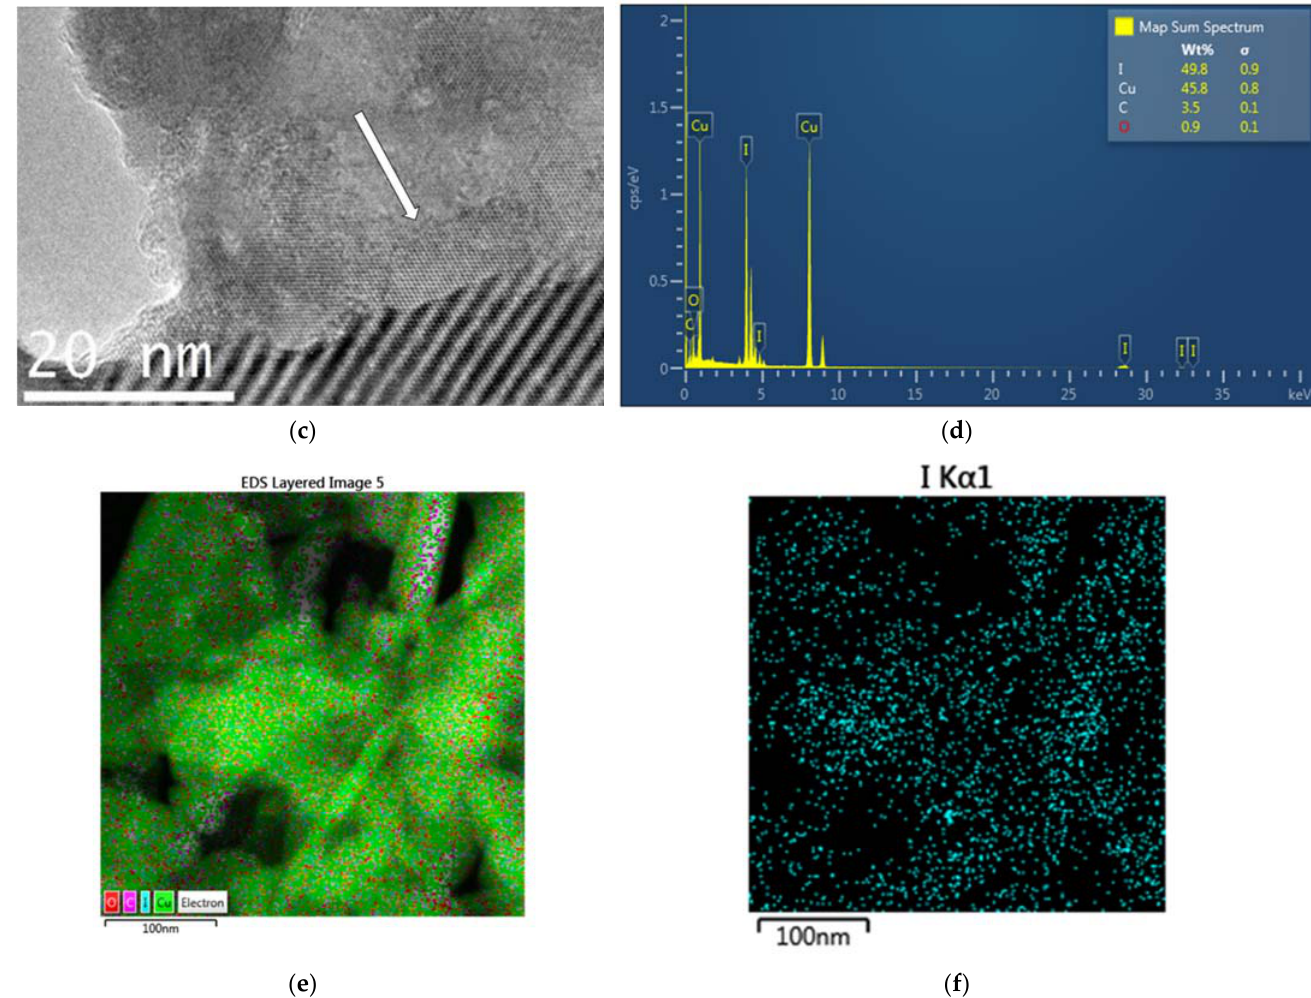
Figure 6. Transmission electron microscopy (TEM) of [Cu(12-crown-4) 2 ]I 5 : ( a ) 20 nm; ( b ) 5 nm with average d-spacing of lattice fringes; ( c ) direction of the main lattice fringes in comparison to the black-white colored barrel-like structures; ( d ) Energy dispersive spectroscopy (EDS); layered images: ( e ) all atoms; and ( f ) I ‐ atom.